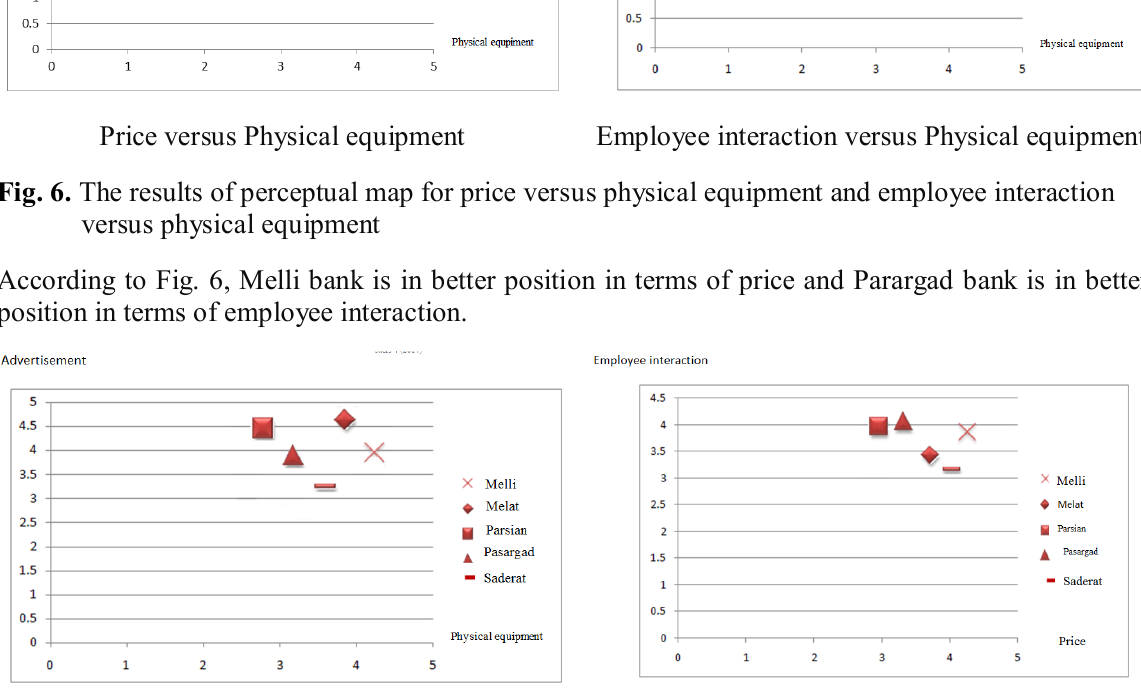
Fig. 7. The results of perceptual map for advertisement versus physical equipment and employee interaction versus